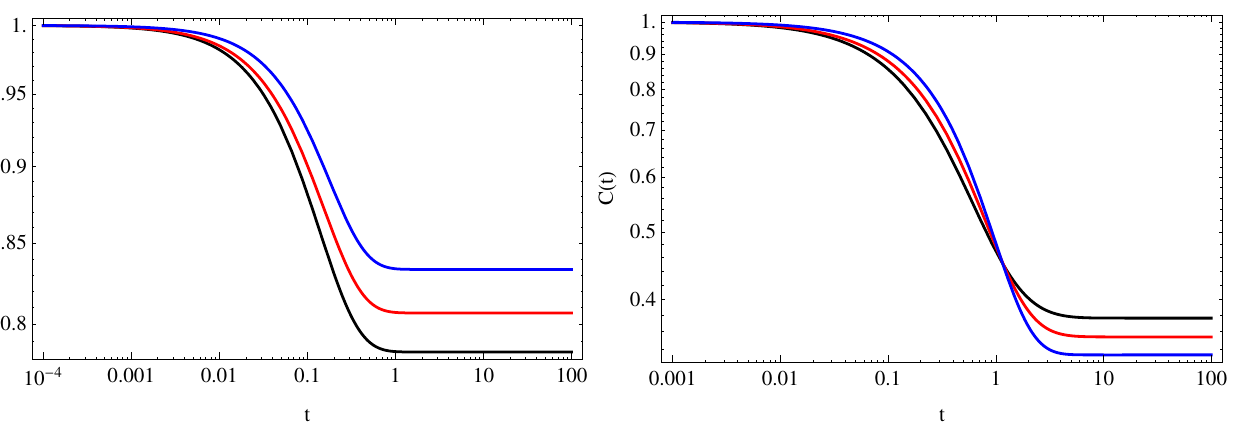
Figure 8. Behaviour of the correlation function (74). The parameters are taken as follows: τ c = 1, τ = 1, a 1 = a 2 = 1/2, and α = 1 (Debye relaxation with resetting, blue line), α = 3/4 (red line), α = 1/2 (black line). Left panel : r = 5; Right panel : r =